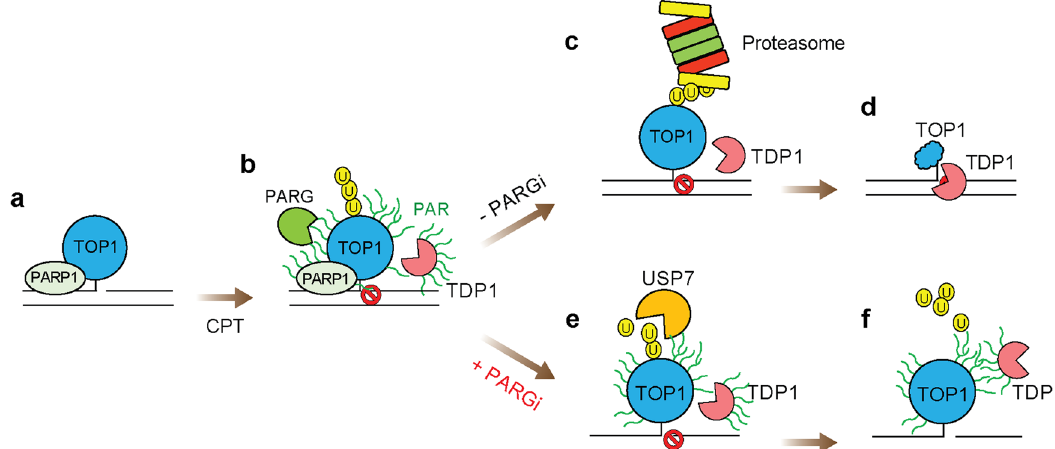
Fig. 6 Model for the role of PARG in the repair of TOP1-DPCs. a PARP1 and TOP1 form cellular protein complexes (present study and refs. 22,34 ). b TOP1- DPC trapped by CPT is rapidly modi fi ed with PAR by PARP1 and with ubiquitin (by RNF4 and potentially other E3 ligases, not shown). The PARylation recruits TDP1, PARG, and USP7 to the TOP1-DPC. c TOP1-DPC PARylation is readily and rapidly reversed by PARG, enabling the 26S proteasome to target the ubiquitylated TOP1-DPC for degradation. d TDP1 hydrolyzes the TOP1 peptide to expose the DNA ends for repair. e In the presence of PARGi, TOP1- DPC dePARylation is blocked and the persistent PAR polymers on TOP1-DPC obstruct the proteasome hence stabilize TOP1-DPC. f The stabilization of TOP1-DPC triggers USP7 to deubiquitylate the DPC to recycle the ubiquitin